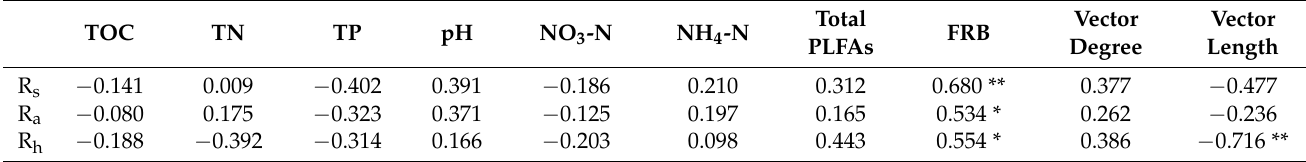
Table 3. The correlation coefficients between soil respiration and its components and soil biotic and abiotic factors.